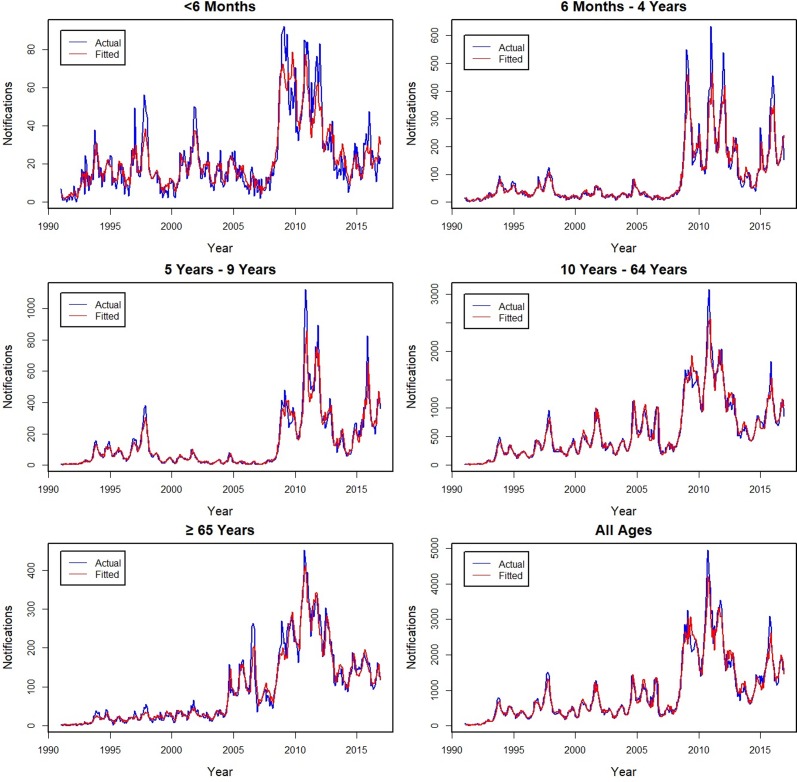
Actual (blue −) and fitted (red −) monthly pertussis notifications from January 1991 to December 2016 by age groups and for all ages (from upper left: <6 months, 6 months to 4 years, 5–9, 10–64, ⩾65 years and all ages).